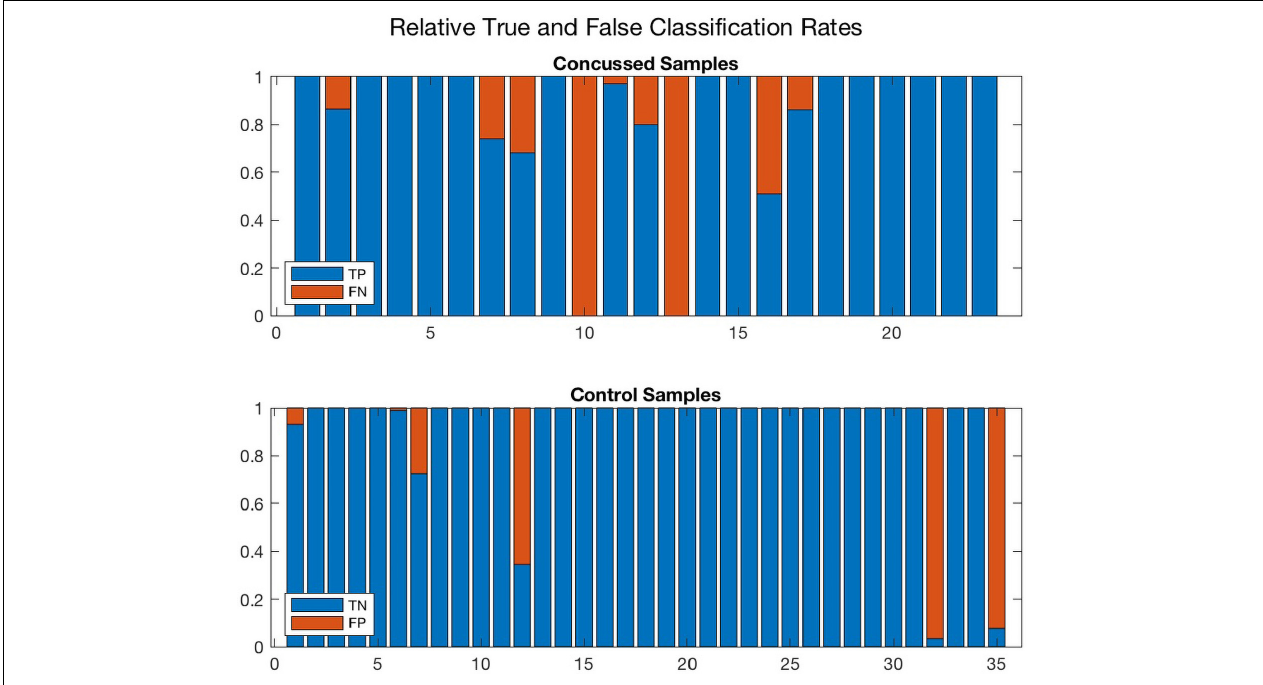
FIGURE 9 | A bar plot representation of the Monte Carlo cross validation test results obtained by means of the ConcNet 2 ensemble of networks (using all 64 channels as input) for the concussed (top) and control (bottom) participants. The blue and red regions in each column illustrate the relative fractions of times that a participant was properly or wrongly classified by the MCCV ensemble. This figure is complementary to Figure 4 which shows the ConcNet 2 median and quartile scores per participant. Three control and two concussed participants were systematically misclassified by the networks in the